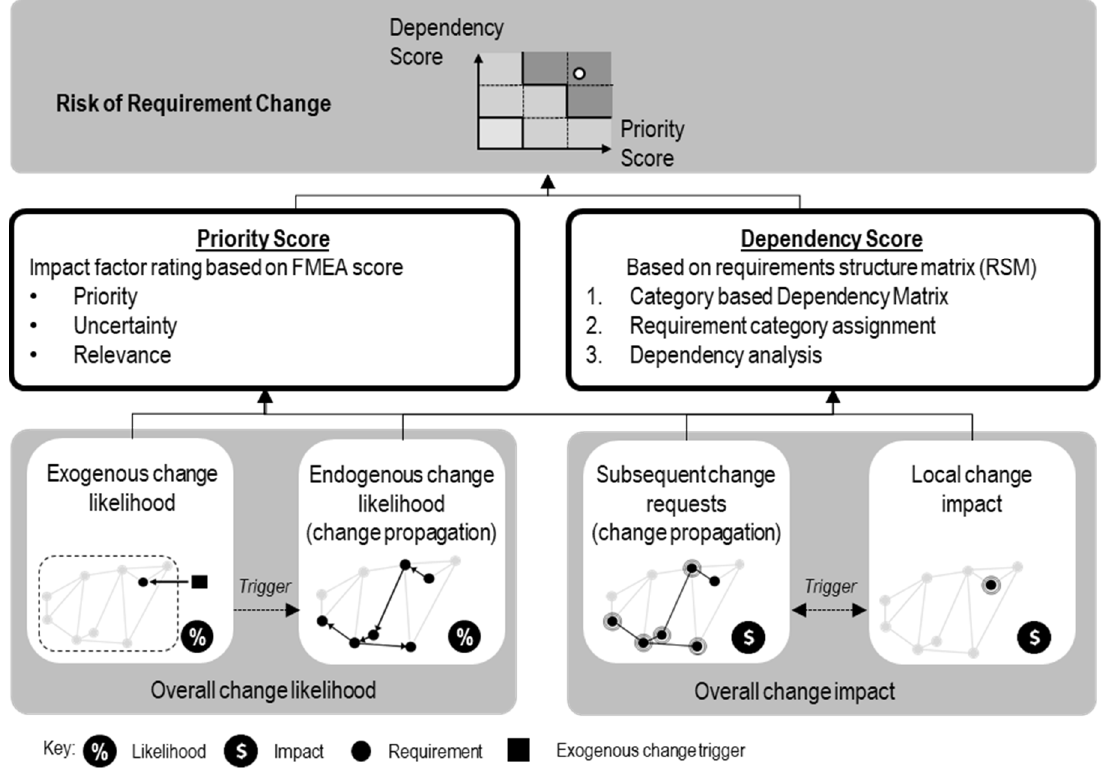
Figure 8. Method for systematic assessment of requirement change risk.